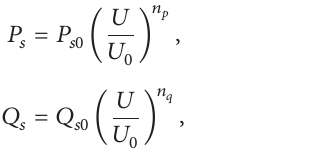
Figure 1: The structure diagram of